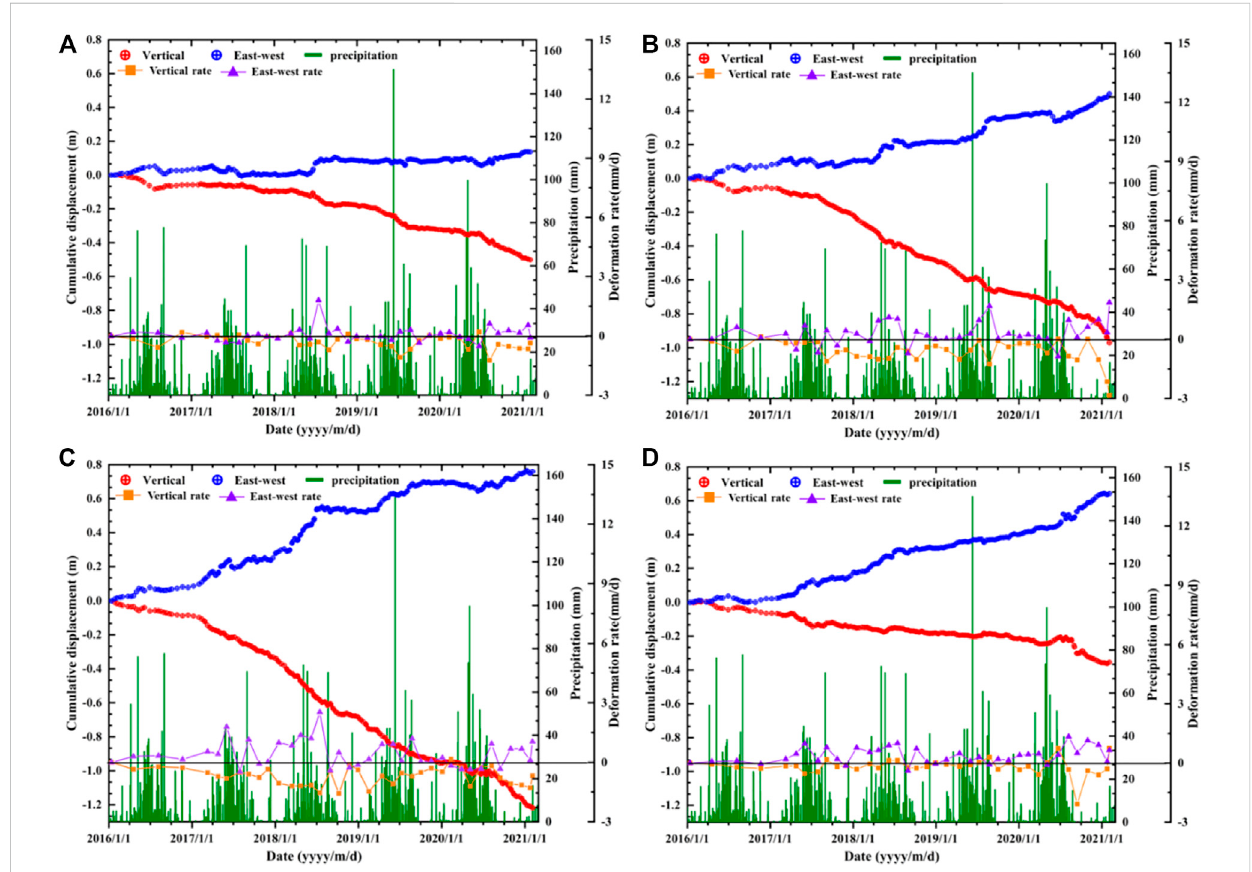
FIGURE 10 Comparison between deformation time series and daily precipitation acquired from GPM. The locations of S1, S2, S3 and S4 are shown in Figure 8. (A, B, C) and (D) are comparison betweentwo-dimensional deformation time series, two-dimensional deformation rate and daily precipitation for S1, S2, S3 and S4, respectively.